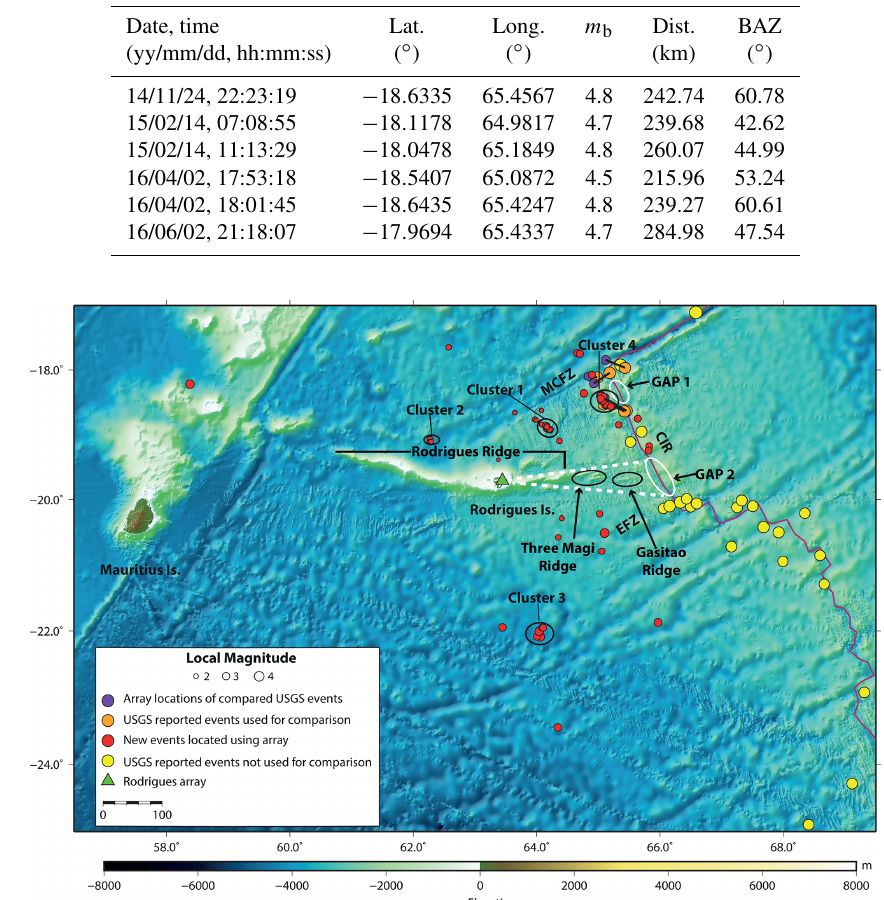
Figure 9. Locations of new events (and clusters) detected and located using array methods are shown by red circles. The purple circles repre- sent event locations from the array analysis in comparison to the events (orange circles) from the USGS catalogue between September 2014 and June 2016. The black bars pair the respective events. Yellow circles denote events from the USGS catalogue for the same recording period that were not (clearly) detected at the Rodrigues array and that were therefore not used for a comparison. The empty GAP 1 and GAP 2 have been demarcated by white ellipses. The dashed white line marks the possible region of partially molten material below the eastern extension of Rodrigues Ridge. CIR, Central Indian Ridge (solid red line); MCFZ, Marie-Celeste fracture zone; and EFZ, Egeria fracture